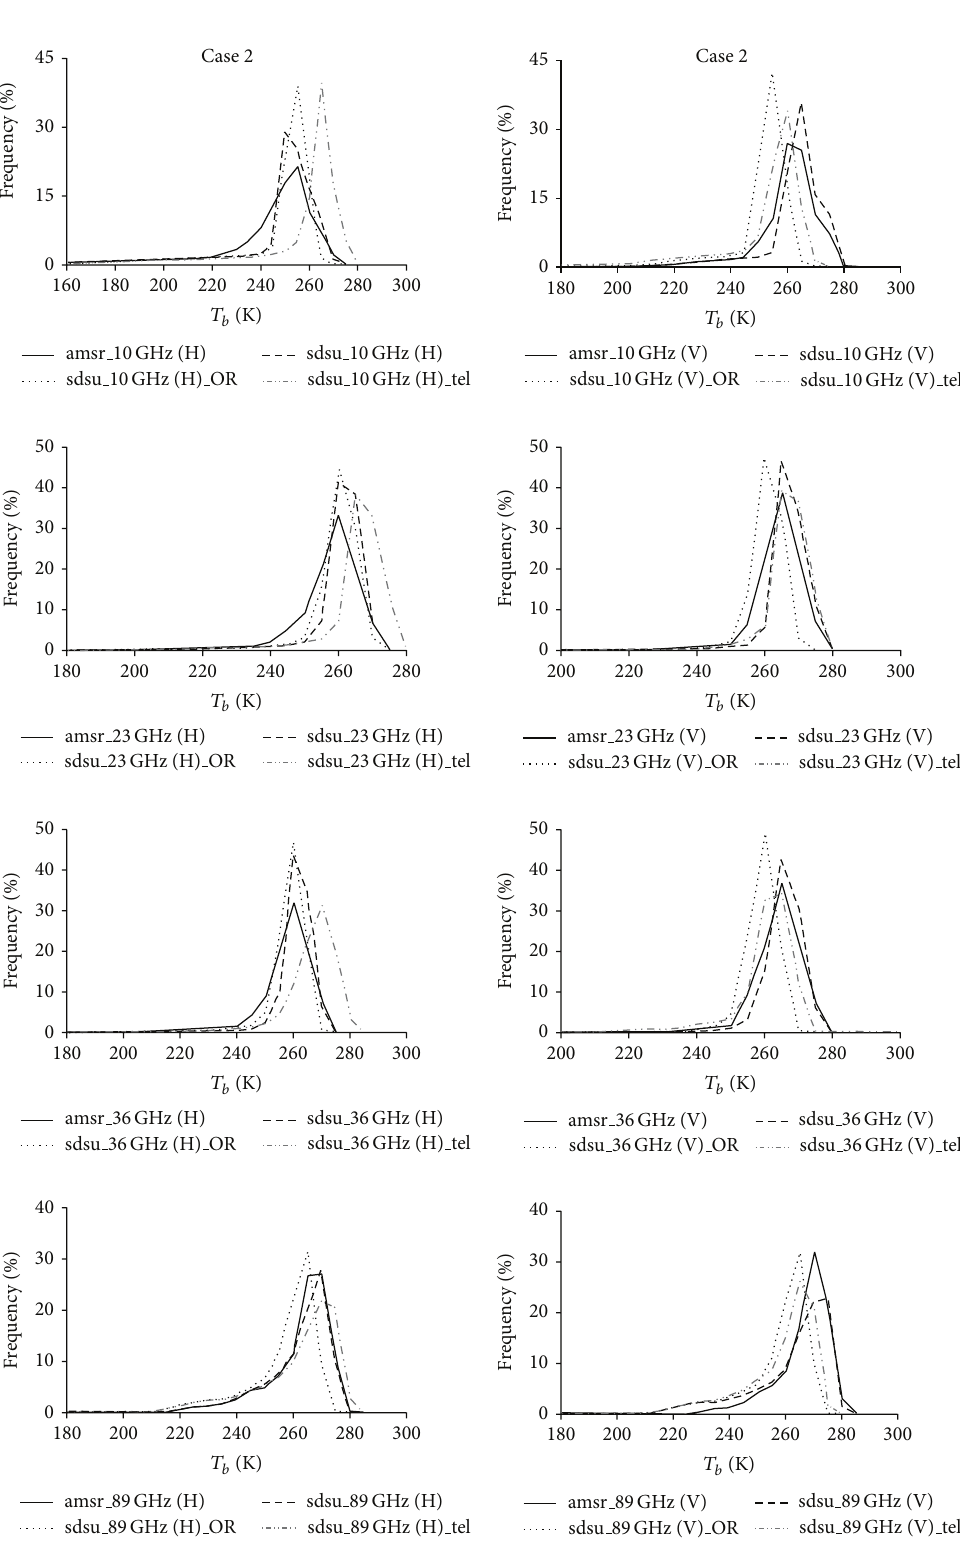
Figure 6: Same as in Figure 5, for the case of 15 February